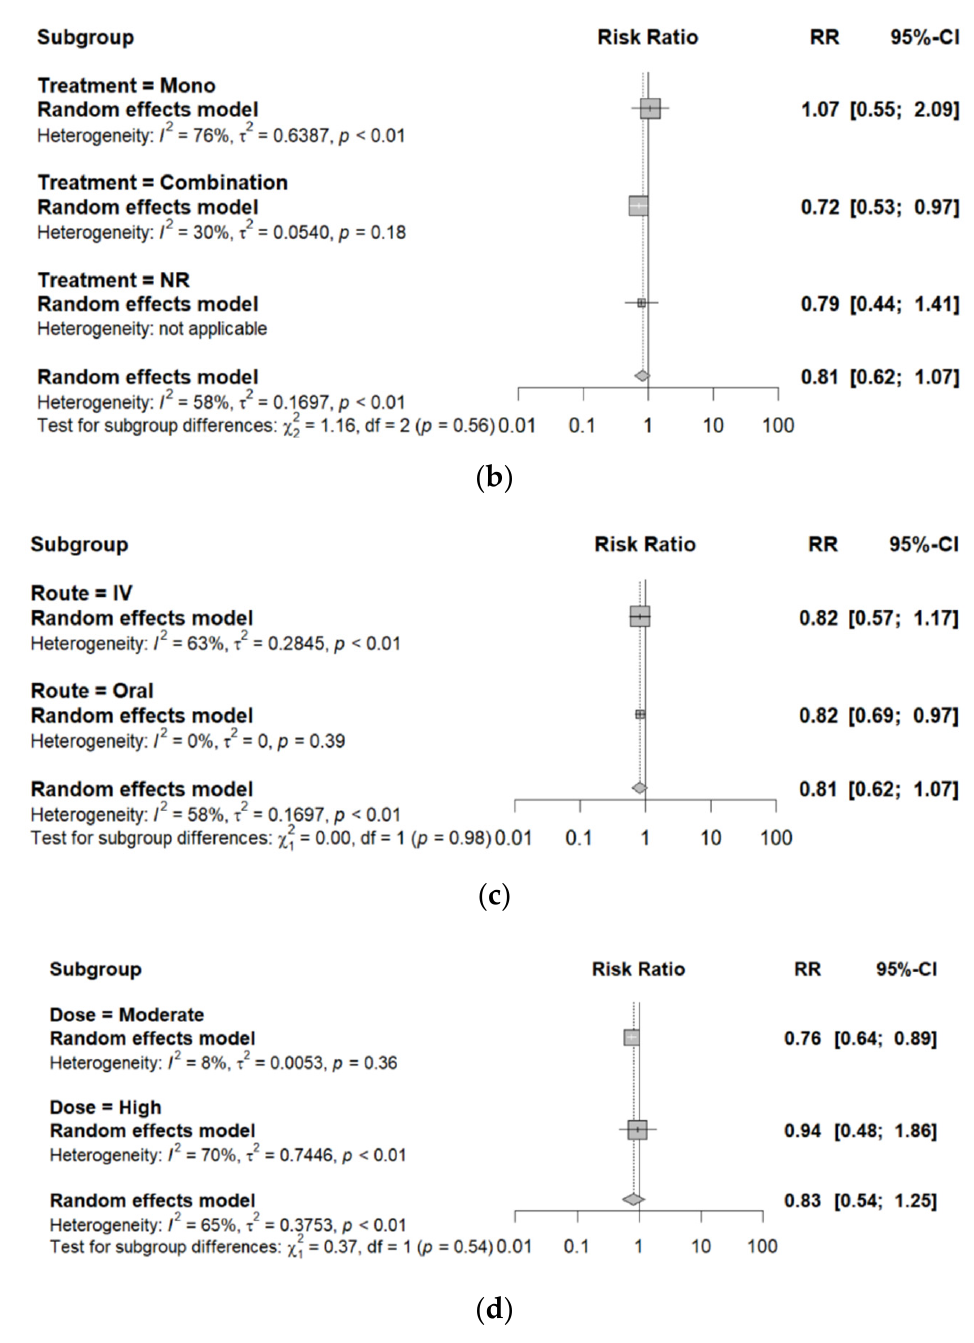
Figure 4. Subgroup analysis for all-cause mortality according to ( a ) study design (non-RCT vs. RCT), ( b ) treatment method (monotherapy vs. combination therapy), ( c ) route (IV vs. oral), and ( d ) dosage (moderate vs. high). Table 3. Egger’s linear regression test for publication